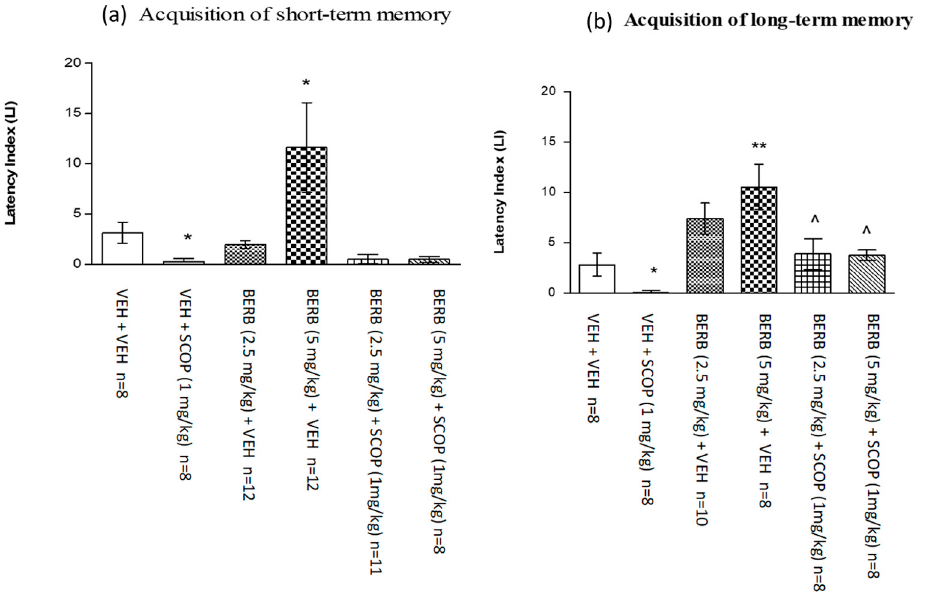
Figure 7. The influence of an acute administration of berberine (BERB) on the memory impairment induced by an acute injection of scopolamine (SCOP), expressed as latency index (LI) during the short-term ( a ) or long-term ( b ) memory acquisition using the PA test in mice. A non-effective dose of BERB (2.5 mg/kg), effective dose of BERB (5 mg/kg) or vehicle were administered 15 min before vehicle or SCOP (1 mg/kg) injection. All drugs were administered 15 min before the first trial and animals were retested 2 h (for short-term memory) or 24 h (for long-term memory) later; n = 8–12; the means ± SEM; * p < 0.05; ** p < 0.01 vs. VEH/VEH-treated group; ˆ p < 0.05 vs. VEH/SCOP (1 mg/kg)-treated group; Tukey’s